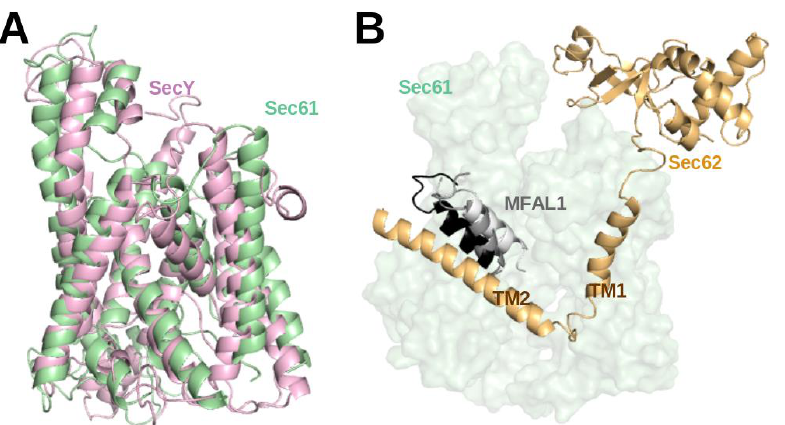
Figure 4. ( A ) Structural superposition of atomistic structures of SecY (light violet) and Sec61 (green). ( B ) Representative structures from a molecular dynamics simulation of SP bound Sec61 from yeast (unpublished). The conformations of the SPs at 0 ns, 500 ns, and 1 µs are coloured white, grey and black, respectively. For this, PDB entry 7AFT [5] detailing the cryo-EM structure of the signal sequence of Mating factor alpha-1 (MFAL1; UniProt ID: P01149) was used to model the SP (M1-A19) at the lateral-gate. The MD simulation was conducted in the presence of a part of Sec62 (orange) in a similar manner to